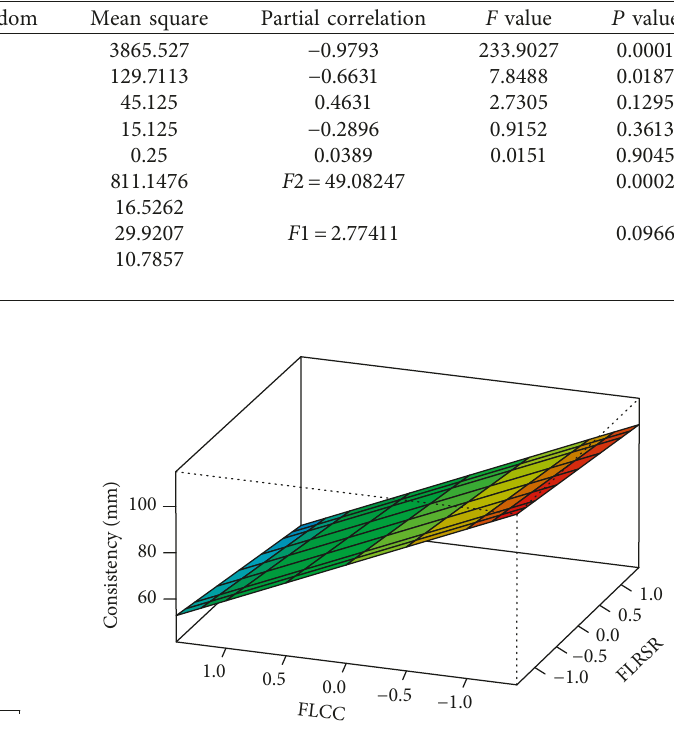
Figure 10: Schematic diagram of consistency.